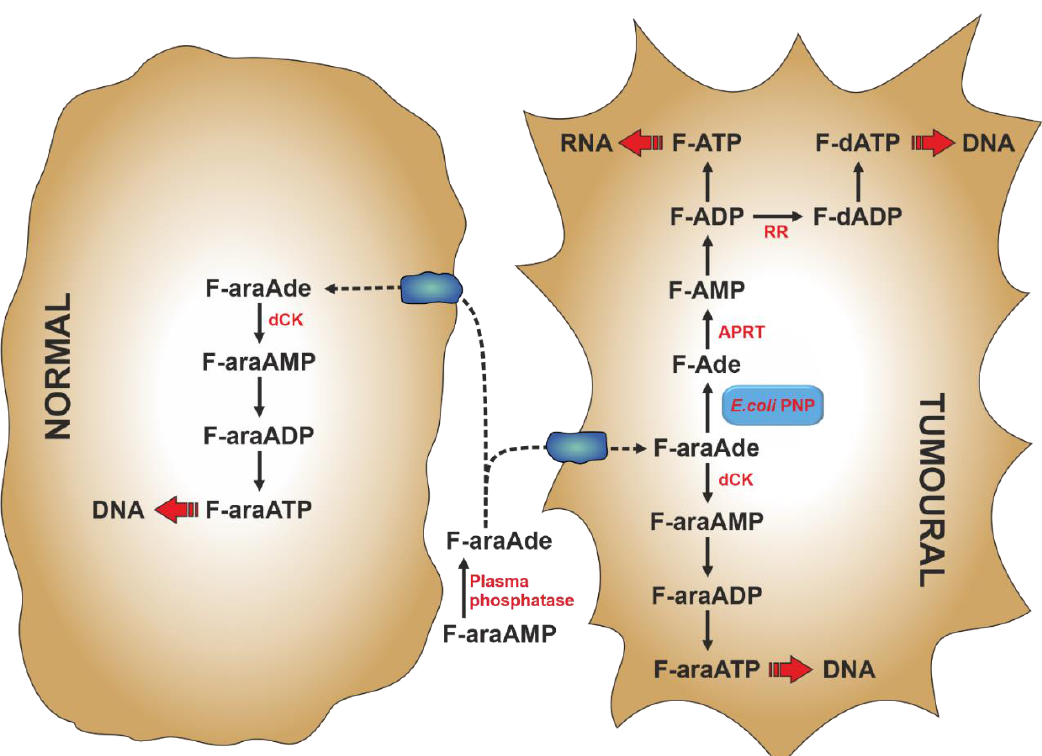
Figure 4. Metabolism of F-araAMP in normal and tumoural cells subjected to Escherichia coli PNP (ePNP) / F-araAMP GDEPT. 9- β -arabinofuranosyl-2-fluoroadenosine 5’-monophoaphate (F-araAMP) is cleaved by plasma phosphatases into 9- β -arabinofuranosyl-2-fluoroadenine (F-araAde), which enters both normal and tumoural cells. Inside the cell, it is activated to the monophosphate by cellular deoxycytidine kinase (dCK). In tumour cells, the presence of ePNP allows for an additional activation pathway, which proceeds through a phosphorolytic cleavage to give 2-fluoroadenine (F-Ade), which is activated by cellular adenine phosphoribosyltransferase (APRT). Through the action of ribonucleotide reductase (RR), F-ADP is converted to the respective deoxynucleotide, thus interfering also on DNA synthesis. GDEPT: gene-directed enzyme prodrug